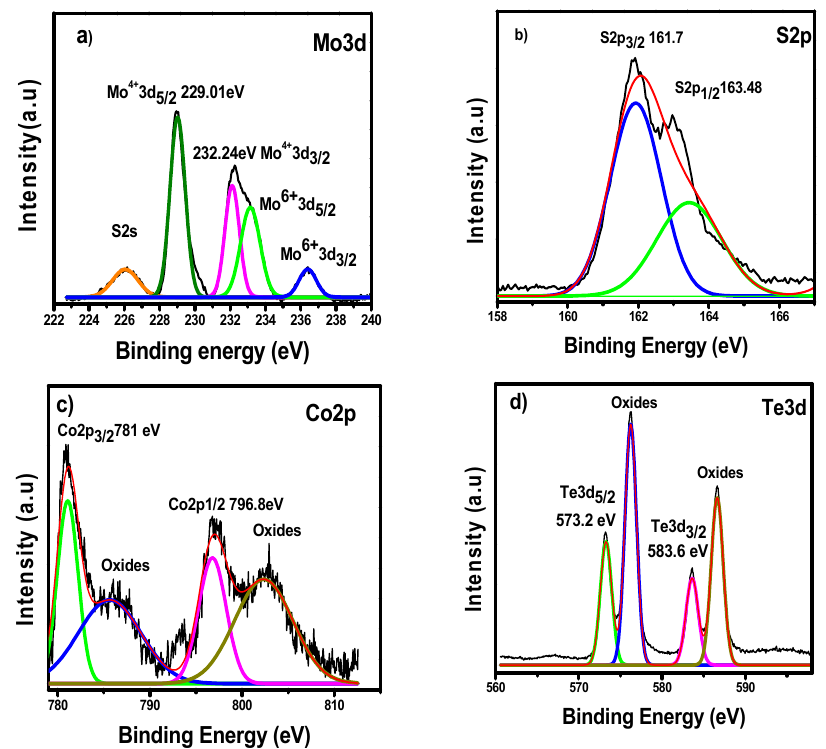
Figure 3. XPS spectra of MoS 2 ( a ) Mo3d, ( b ) S2p and CoTe ( c ) Co2p, ( d ) Te3d.